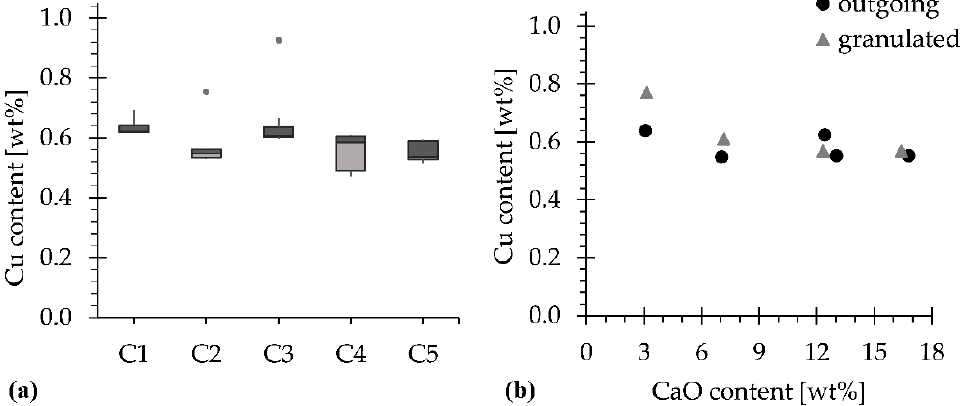
Figure 4a presents a box plot of the copper content in all samples of the outgoing slag in batch C1–C5. Two values are marked as outliers (grey dots) in the plot, these values were excluded from the calculated average copper content in the batches (presented in Table 3). Figure 4b presents the copper content in the outgoing and granulated slag plotted against the CaO content. The slag copper content decreased with increasing CaO content in the granulated slag from 0.77 wt % in C1 to 0.57 wt % in C4 and C5. For the outgoing slag, the copper content is highest in C1 (0.64 wt %) and lowest for C2, C4, and C5 (0.55 wt %). The settling temperature was about the same (1247–1252 ◦ C, Table 1) for all batches except for C4, which had a temperature of 1223 ◦ C. No correlation was observed between the outgoing slag copper content and the temperature.